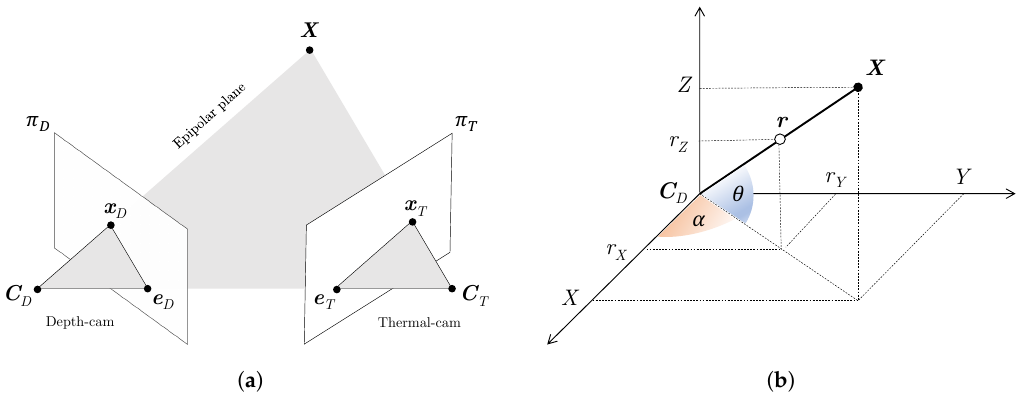
Figure 3. Epipolar geometry relations between the calibrated depth and thermal cameras ( a ) and 3D coordinates reconstruction of a given point X with known depth value (distance from the center of projection of the depth camera, C D ) and optical ray r ( b